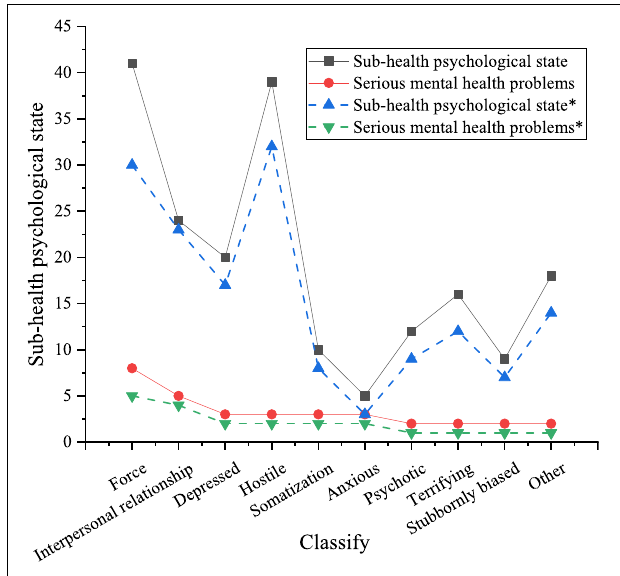
FIGURE 10 | Different mental illnesses of college students in sports majors in Shaanxi Province under the background of two kinds of